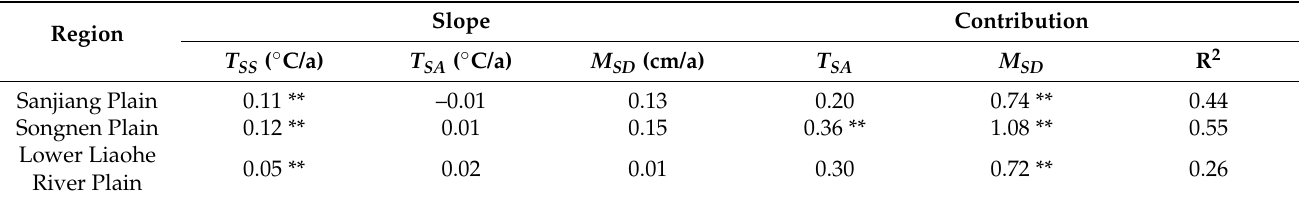
Figure 5. The linear trend of the annual average T SS and T SA from 1979 to 2018 in the Sanjiang Plain ( a ), the Songnen Plain ( c ), and the lower Liaohe River Plain ( e ). Also shown are the linear trend of the annual average T DSSA from 1979 to 2018 in the Sanjiang Plain ( b ), the Songnen Plain ( d ), and the lower Liaohe River Plain ( f ). ( a , c , e ) show the M SD over the years 1979–2018 in three regions. Table 2. The slopes between anuual average M SD , T SA , and T SS in three plains in NEC and the contribution of M SD and T SA to T SS in each region of NEC from 1979 to 2018.